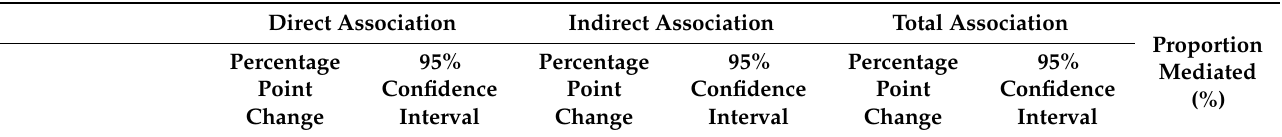
Panel A: Direct and indirect associations of the prenatal PM 2.5 exposure